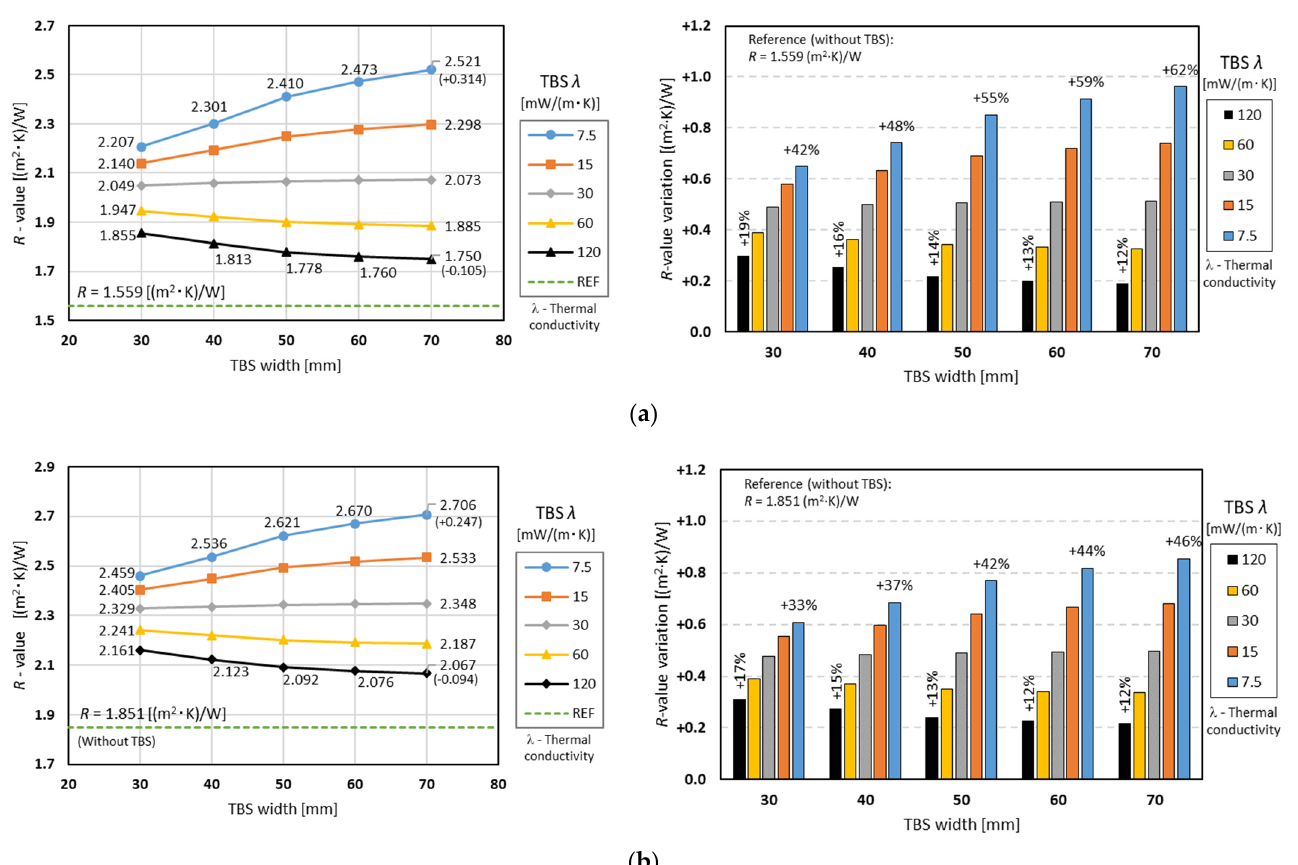
Figure 6. Surface-to-surface thermal resistance for LSF partitions, with one thermal break strip: 10 mm thick and variable width, for two different steel stud spacings. ( a ) 400 mm stud spacing. ( b ) 600 mm stud spacing.